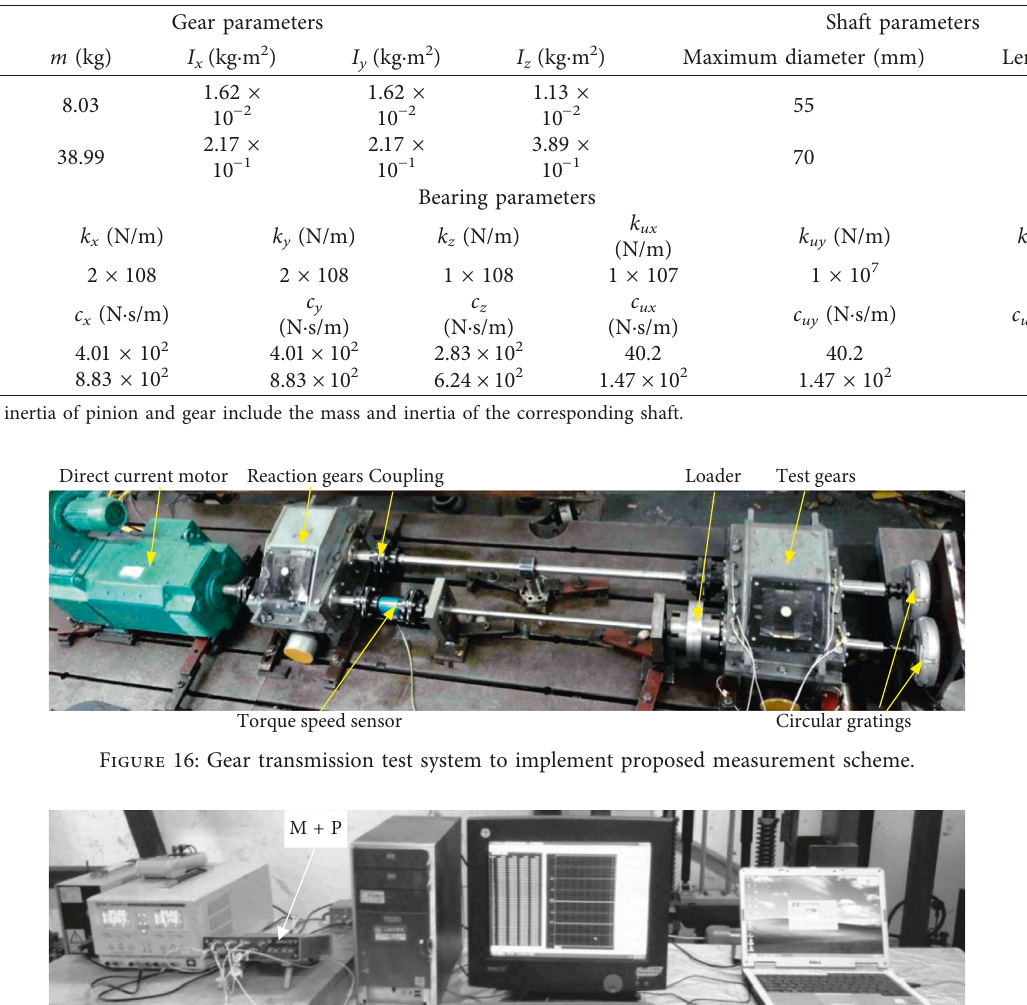
Figure 15: Relative rotational displacement in (a) case one and (b) case two. Table 3: Parameters of example system.